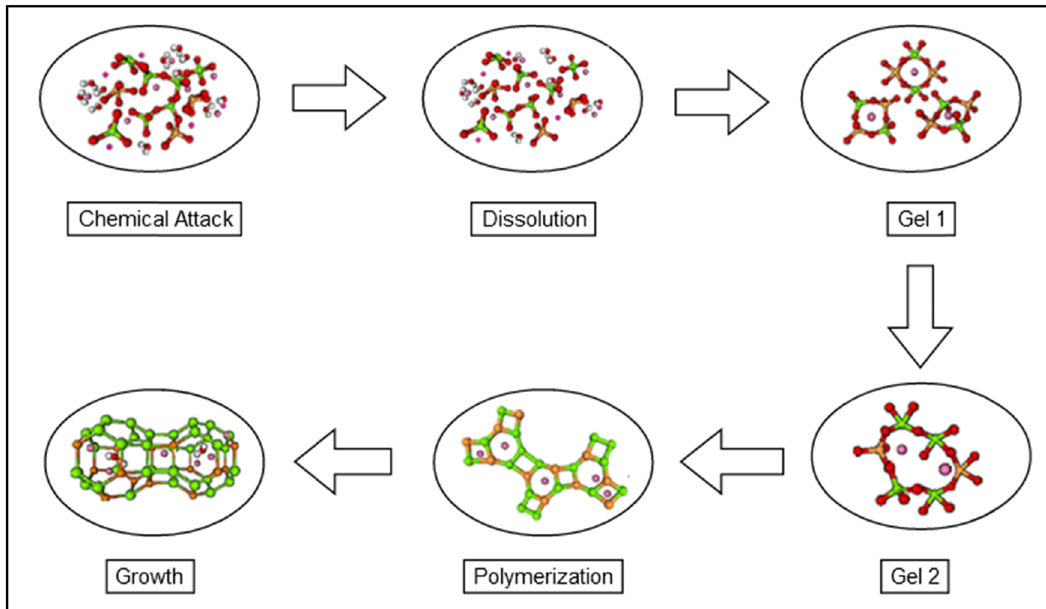
Figure 2: Conceptual design of geopolymerization